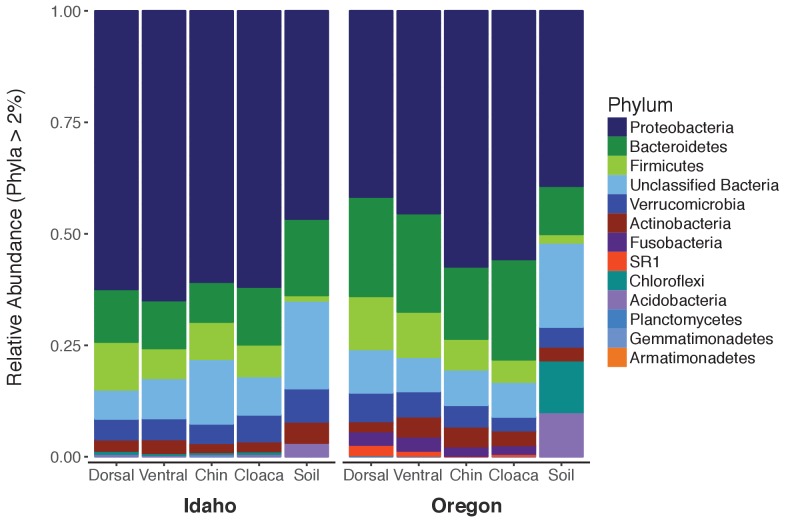
Relative abundance of newt-associated bacteria at the phylum level.Newt skin communities are diverse, with bacterial OTUs from 12 distinct phyla present at >3% relative abundance.